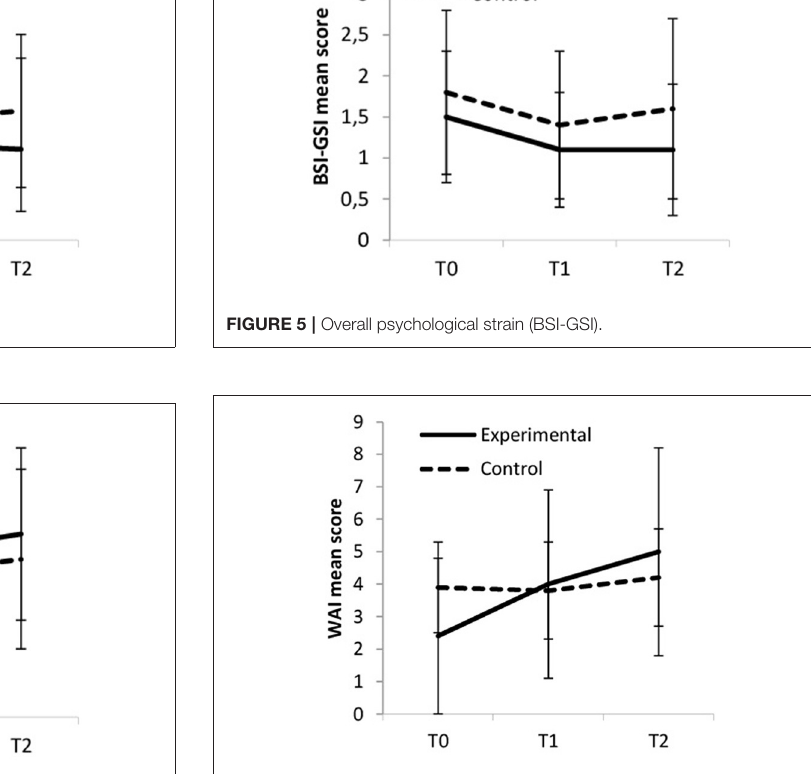
FIGURE 6 | Work ability index